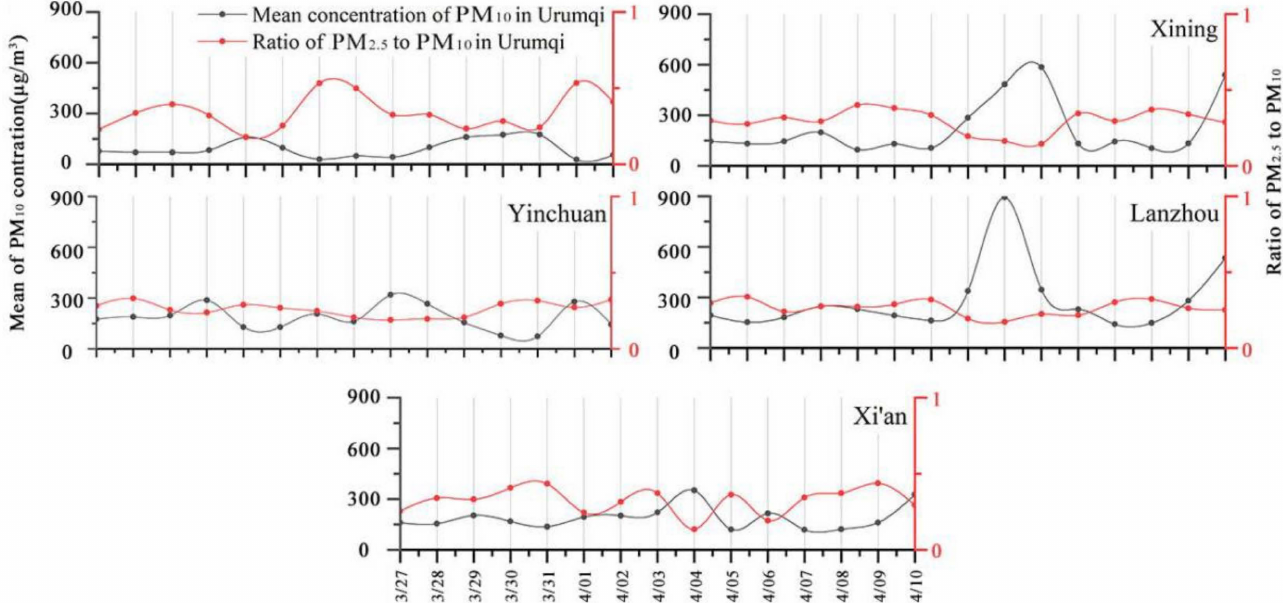
Figure 2. Changing trend of the concentration of PM 10 and PM 2.5 /PM 10 ratio of the period relevant to the sandstorm event in April 2018, for the case study